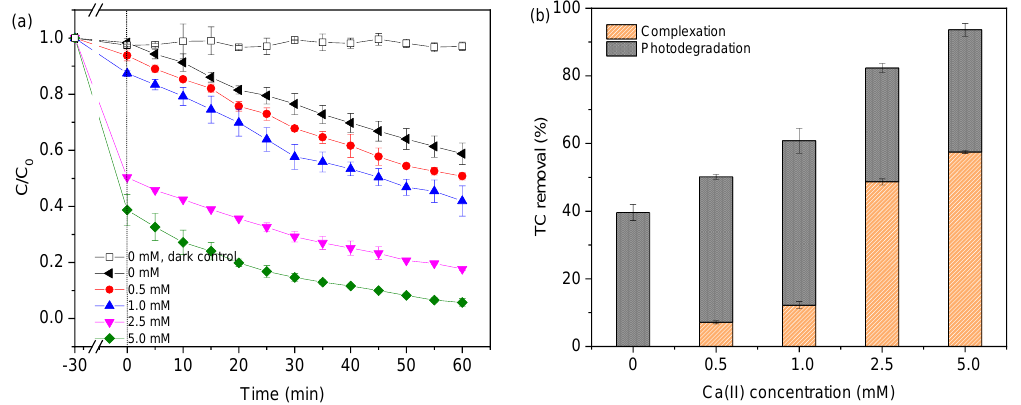
Figure 1. Photolytic degradation of tetracycline (TC) with increasing Ca(II) concentrations. Plot of C / C 0 versus irradiation time ( a ), TC removal percentages by complexation and photodegradation ( b ).